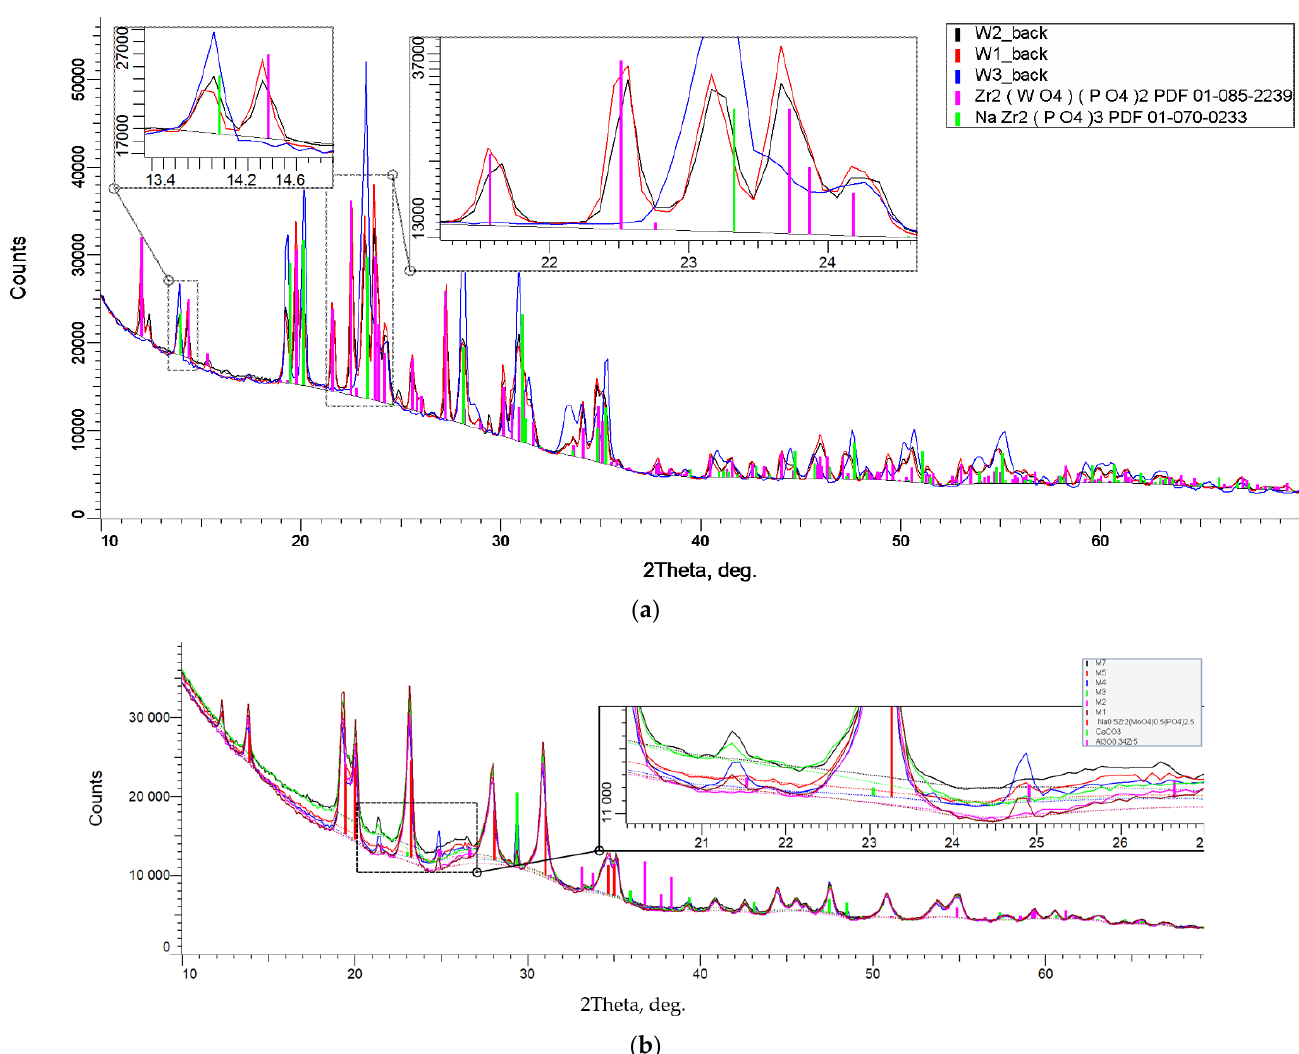
Figure 15. XRD curves of the ceramic samples of phosphate–tungstate Na 1-x Zr 2 (PO 4 ) 3-x (XO 4 ) x ceramics, X = W ( a ), Mo ( b ), with x = 0.5: W1–W3—the labels of three phosphate–tungstate satellite ceramic specimens, M1–M7—the labels of seven phosphate-molybdate